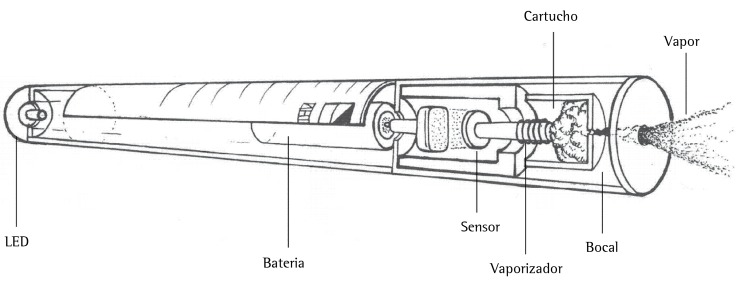
Componentes do cigarro eletrônico. LED: light-emitting diode (díodo
emissor de luz).